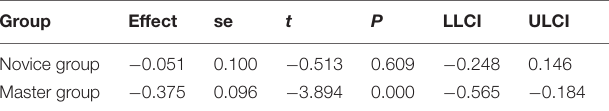
TABLE 13 | Simple slope